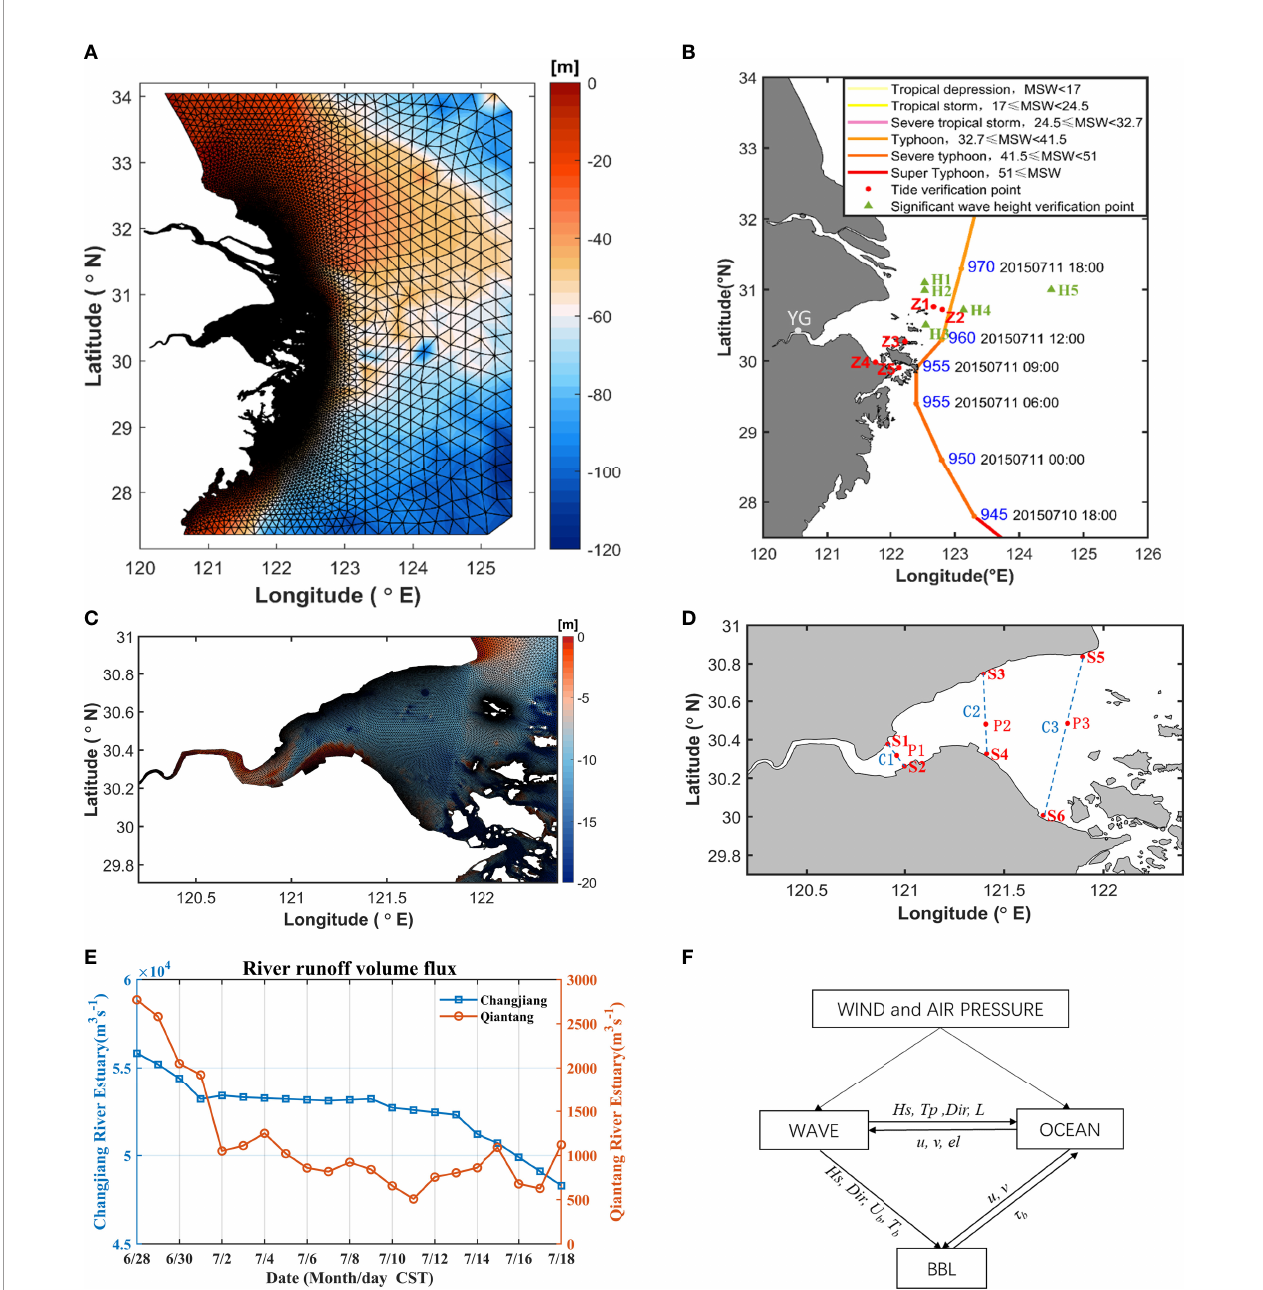
FIGURE 1 | (A, C) Map of Hangzhou Bay and its adjacent seas; grids of the model domain; (B) Typhoon Chan-hom; (D) Distribution of section and feature points. (E) River runoff volume fl ux (F) Schematic of the coupling between FVCOM circulation model (OCEAN) and FVCOM-SWAVE with inclusion of the wave-current bottom boundary layer